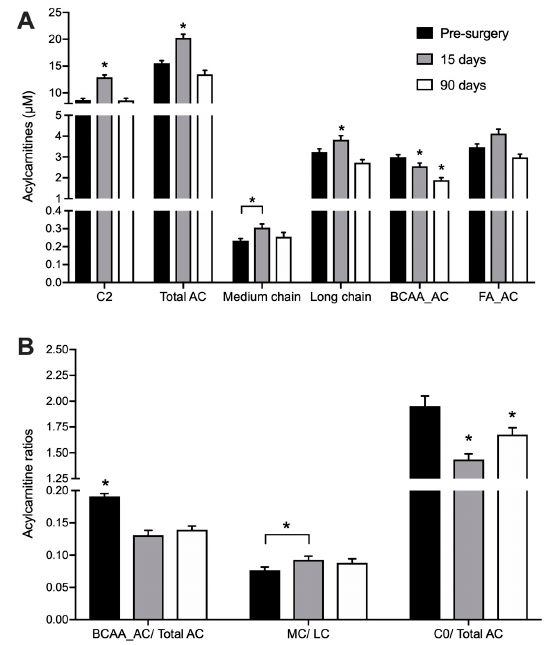
Figure 1. Acylcarnitines in DBS collected before, 15 and 90 days after RYGB. n = 26. * indicates p < 0.05 in comparison to all other groups, unless otherwise indicated. ( A ) C2: acetylcarnitine; Total AC: sum of all quantified acylcarnitines; medium chain: sum of acylcarnitines with 6 to 14 carbons; long chain: sum of acylcarnitines with 16–18 carbons; ( B ) BCAA_AC: sum of acylcarnitines derived from branched-chain amino acid catabolism (C3, 2M-C3, 2M-C4, 3M-C4 and C4DC); FA_AC = sum of medium-chain acylcarnitines derived from fatty acid catabolism (C6, C8, C10, C12, C14, C16, C16:1, C:18, C18:1, C18:2; C0 = L-carnitine.